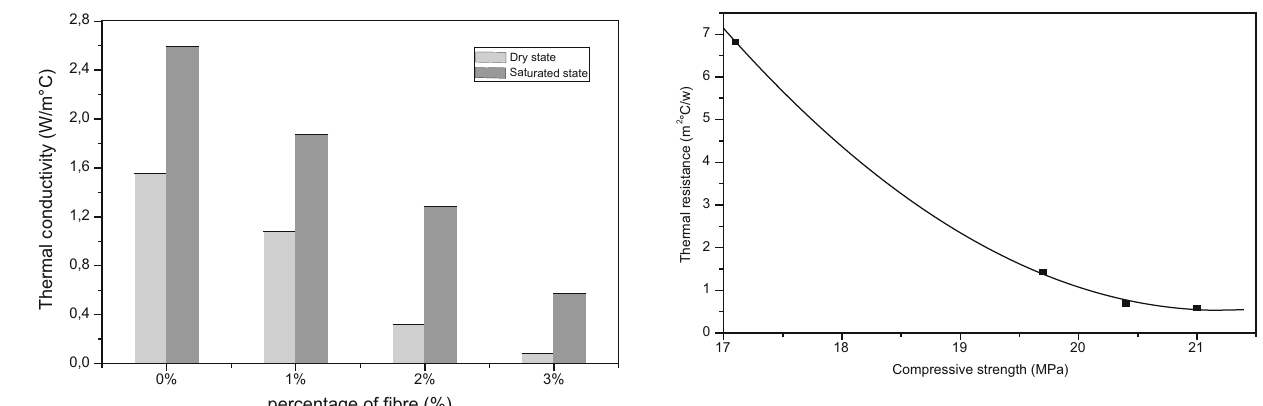
Fig. 6 Thermal resistance of lightened concrete variation as function of compressive strength for various